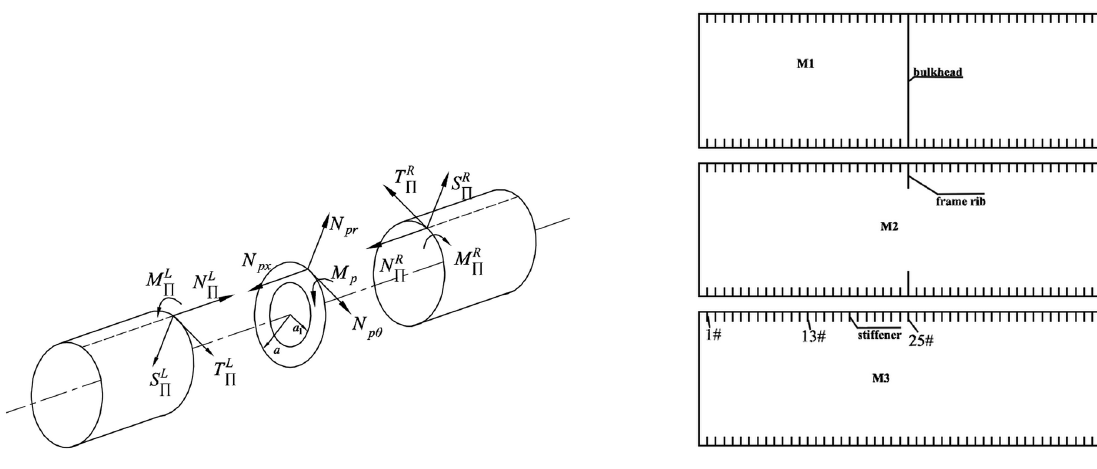
Fig. 4. Annular circular plate and interaction forces. Fig. 5. Ring stiffened cylindrical shells with bulkhead/ intermediate large frame rib/all ordinary